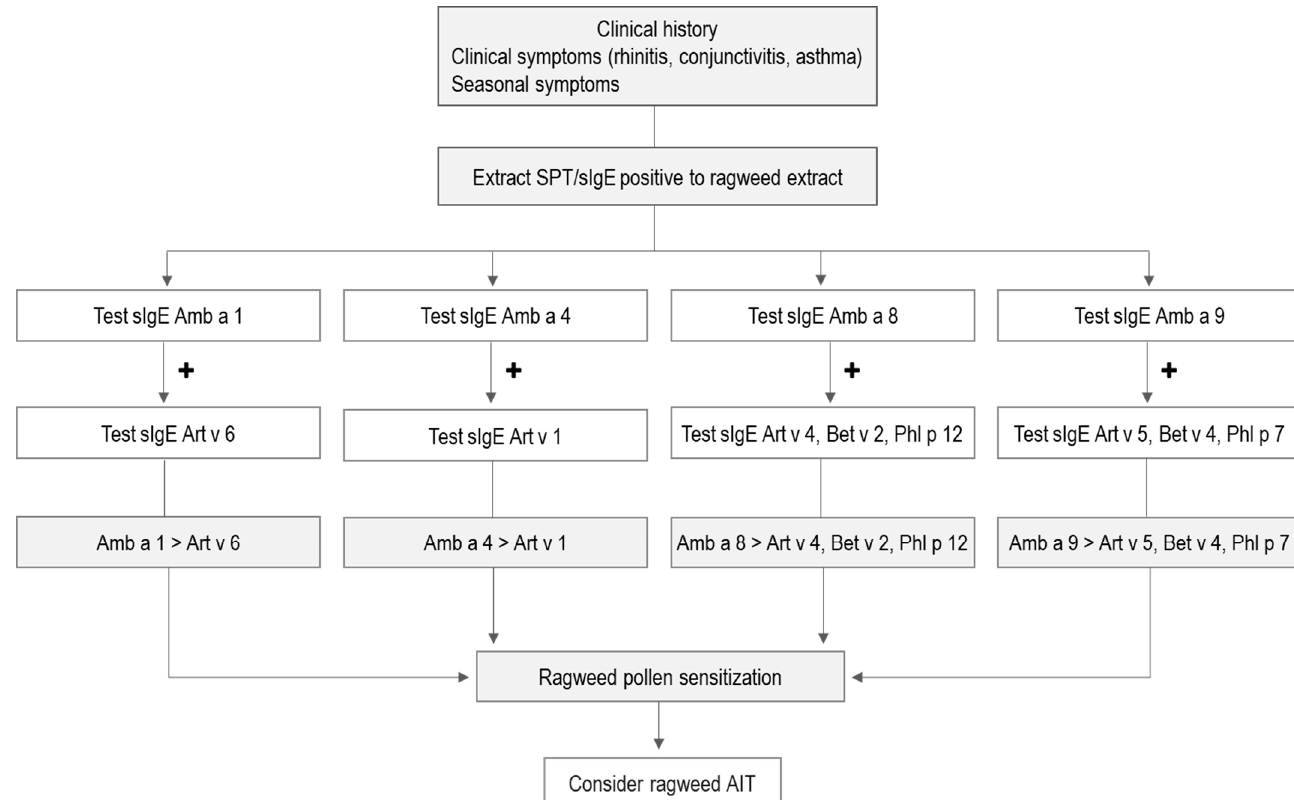
Figure 6. Diagnosis algorithm and decision tree for identification of ragweed pollen allergy by CRD in areas where ragweed, mugwort, birch and timothy grass pollen are found. Patients with symp- toms of allergic rhinitis during the ragweed pollen season and a positive SPT/IgE assay to ragweed pollen extract are further investigated to detect IgE antibodies in serum to Amb a 1, Amb a 4, Amb a 8 and Amb a 9. Additionally, investigation of the IgE antibodies to cross-reactive molecules, ho- mologous to ragweed allergens (i.e., Art v 1, Art v 4, Art v 5, Art v 6, Bet v 2, Bet v 4, Phl p 12 and Phl p 7), are recommended before AIT